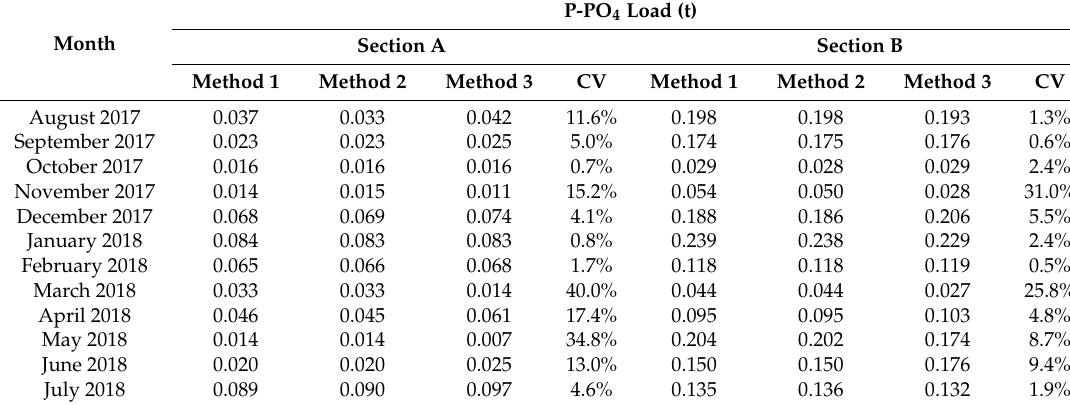
Table 4. Monthly P-PO 4 loads estimated by using the inter-sample mean concentration (Method 1), inter-sample mean concentration using mean flow (Method 2), and linear interpolation of concentration (Method 3) methods. CV is the coefficient of